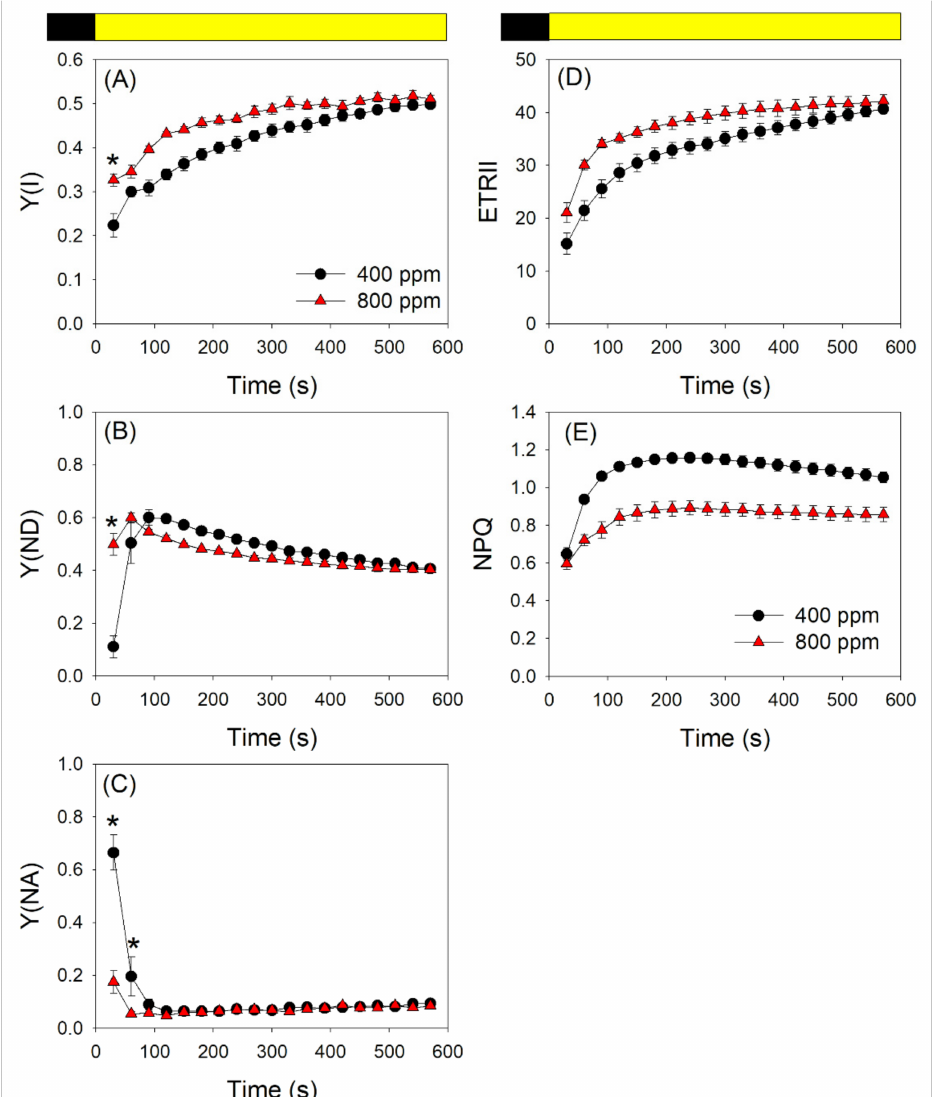
Figure 2. Changes in PSI and PSII parameters after transition from darkness to 272 µ mol photons m − 2 s − 1 in Arabidopsis leaves, measured in 400 and 800 ppm CO 2 . ( A ) Y(I), the quantum yield of PSI photochemistry; ( B ) Y(ND), the quantum yield of PSI non-photochemical energy dissipation due to the donor side limitation; ( C ) Y(NA), the quantum yield of PSI non-photochemical energy dissipation due to the acceptor side limitation; ( D ) ETRII, electron transport rate through PSII; ( E ) NPQ, non-photochemical quenching in PSII. Data are shown as means ± SD ( n = 5). Asterisk indicates a significant different between 400 and 800